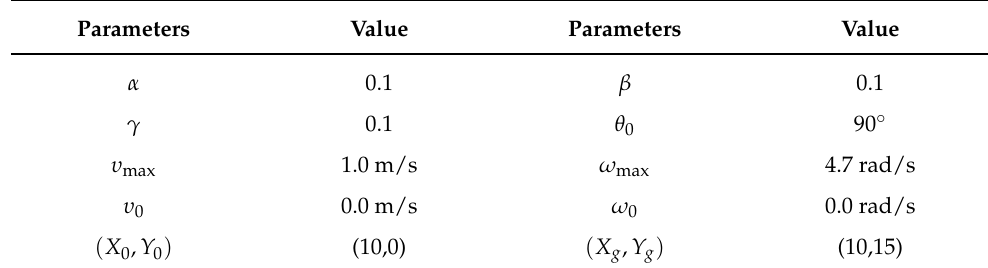
Table 3. Initial parameters of the DWA algorithm.